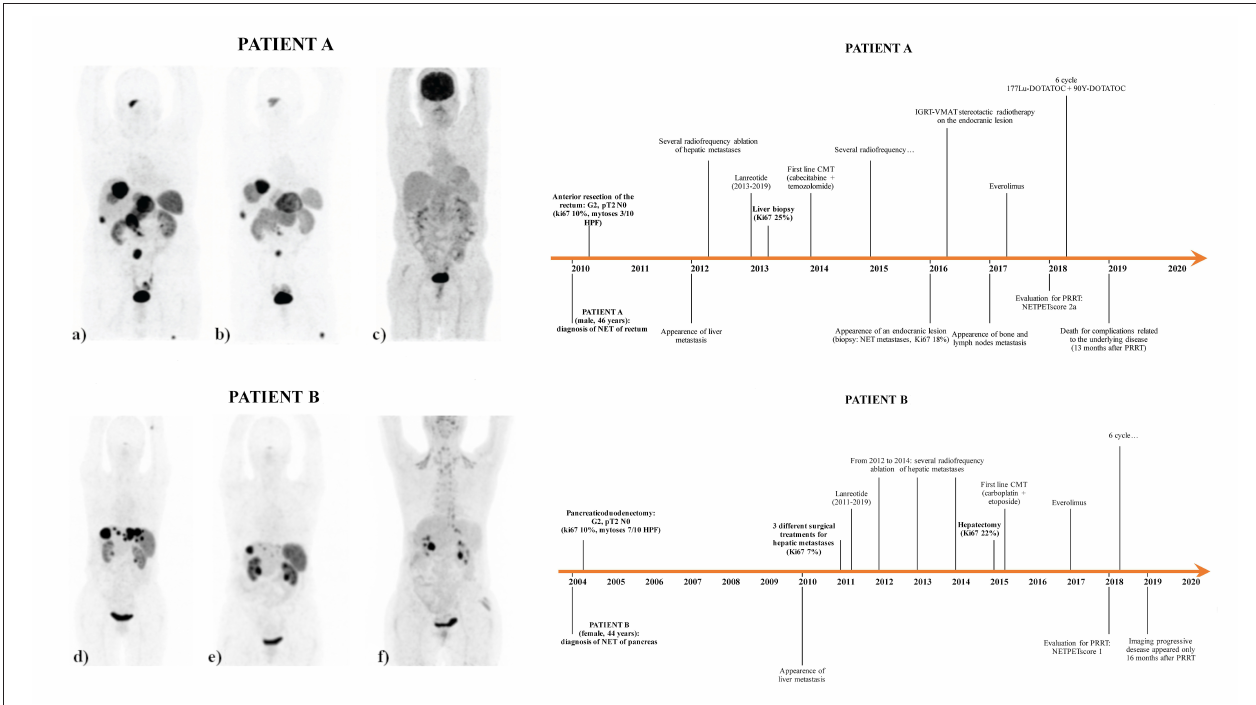
FIGURE 1 | 68 Ga-DOTATOC PET/CT [pre-therapy (a) and post-therapy (b) ] and 18 FDG PET/CT [pre-therapy (c) ] of patient A, 68 Ga-DOTATOC PET/CT [pre-therapy (d) and post-therapy (e) ] and 18 FDG PET/CT [pre-therapy (f) ] of patient B, and patient history timeline of both patient A and patient B. The pre- and post-therapy maximum intensity projection (MIP) of the 68 Ga-DOTATOC PET/CT of patient B, respectively, shows a homogeneous decrease in size and somatostatin receptor expression of all the liver lesions. Patient A received one cycle of 90 Y-DOTATOC (1.7 GBq) followed by six cycles of 177 Lu DOTATOC (total cumulated activity, 26.13 GBq), with a median estimated absorbed dose of 104.5Gy (range: 63–134). Patient B received three consecutive cycles of 90 Y-DOTATOC (cumulated activity of 3 GBq) followed by three cycles of 177 Lu DOTATOC (cumulated activity of 14.30 GBq), with a median estimated absorbed dose of 104Gy (range: